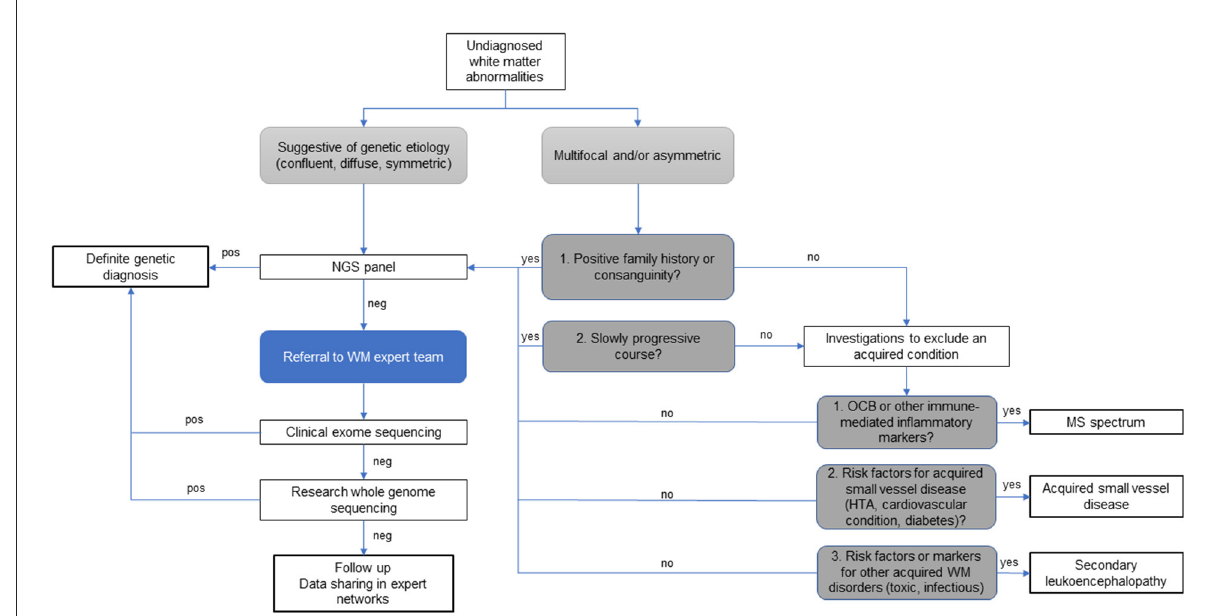
FIGURE5 Diagnostic algorithm for patients with atypical undiagnosed white matter abnormalities. Legend : HT, hypertension; NGS, next generation sequencing; OCB, oligoclonal bands; WM, white matter; pos, indicates the identification of verified disease-causing mutations; neg, indicates when the data analysis is negative or inconclusive.